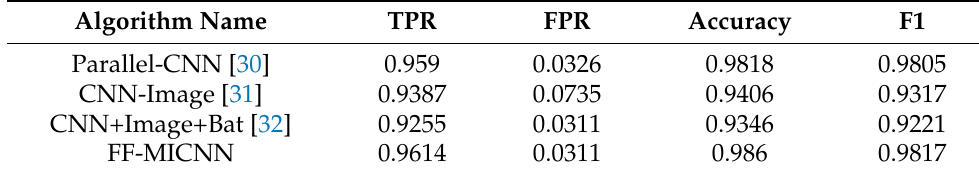
Table 7. The comparison of different methods.